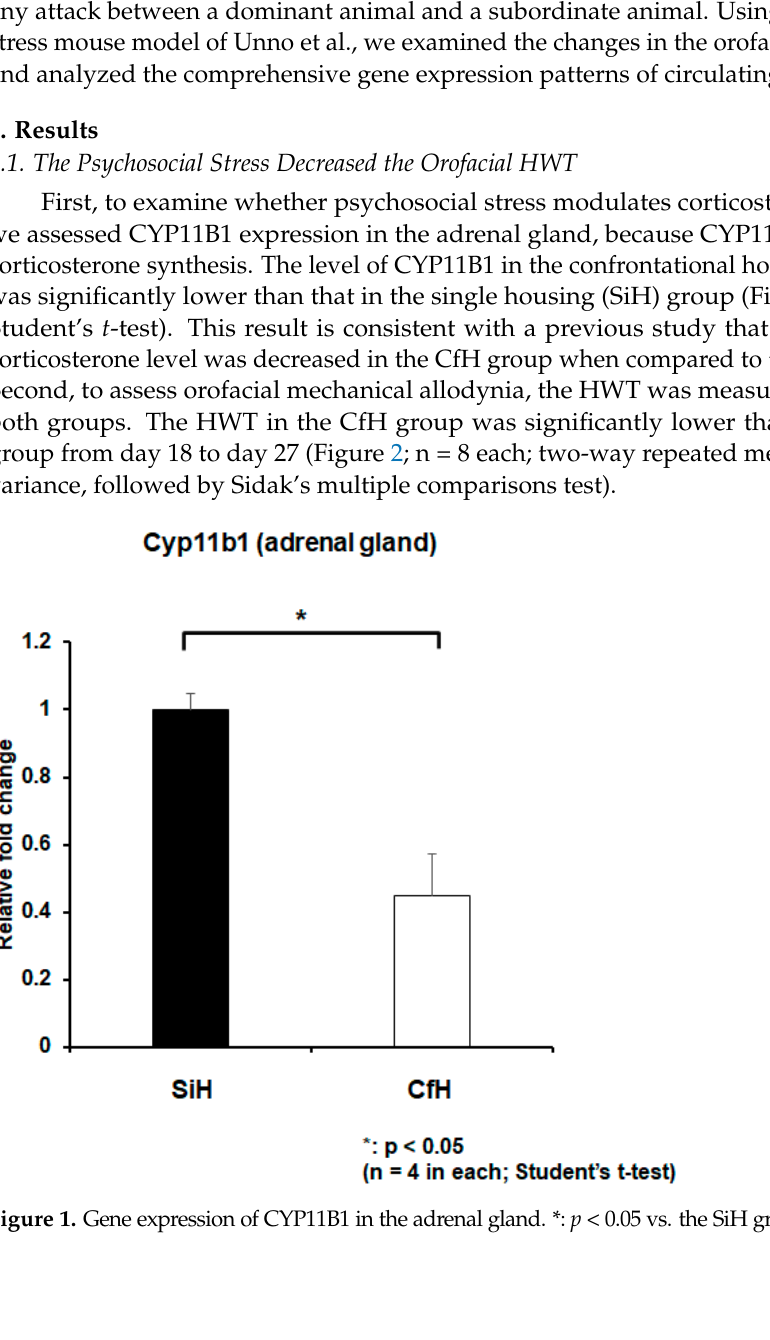
Figure 2. Changes in the HWT in the whisker pad skin over 5 weeks in the SiH and CfH groups. *: p < 0.05, **: p < 0.01, and ***: p < 0.001 vs. the SiH group (two-way repeated measures analysis of variance, followed by Sidak’s multiple comparisons test).